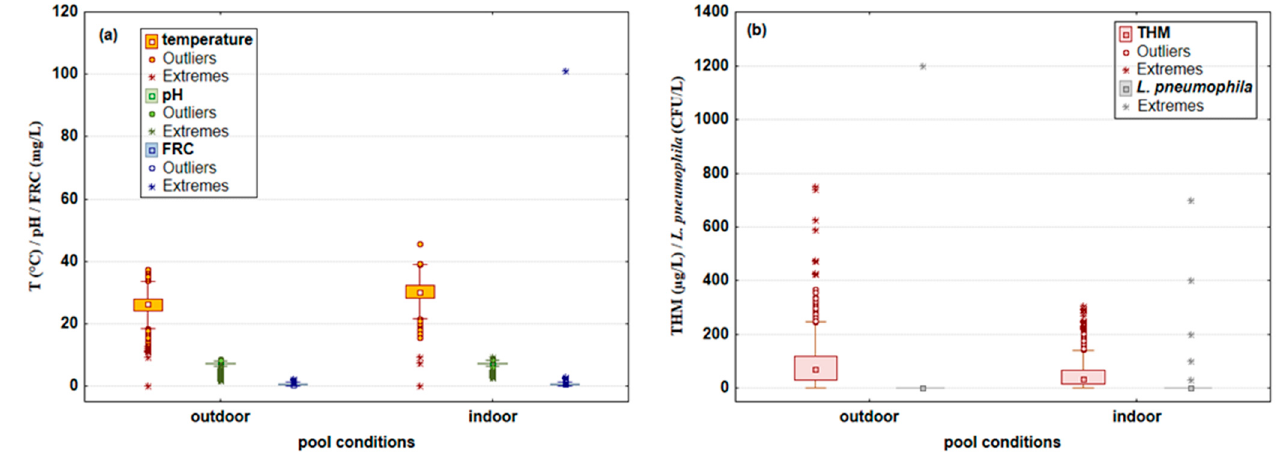
Figure 1. Water’s physicochemical parameters: ( a ) temperature (°C), pH and free residual chlorine (FRC; mg/L), and ( b ) trihalomethanes (THM; µ g/L) and amount of Legionella pneumophila (CFU/L) in outdoor and indoor swimming pools. Results are shown as median, minimum, and maximum values, with outliers and extreme values (N pool data = 4587; N outdoor data = 2233; N indoor data = 2354). The median temperature values in outdoor pools were 26.3 °C (max value 37.3 °C)